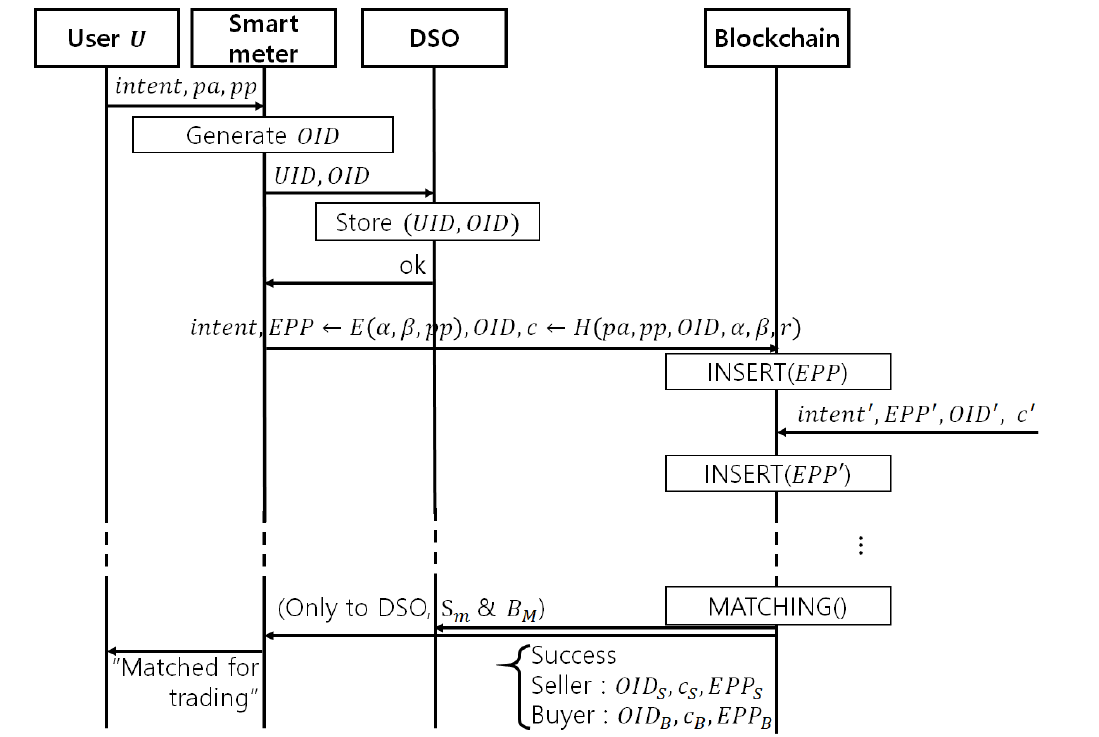
Figure 3. Bidding and matching stage of the proposed